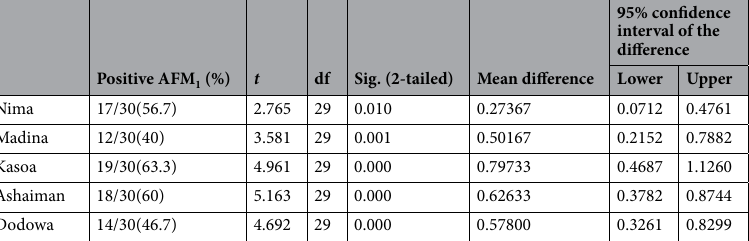
95% confidence interval of